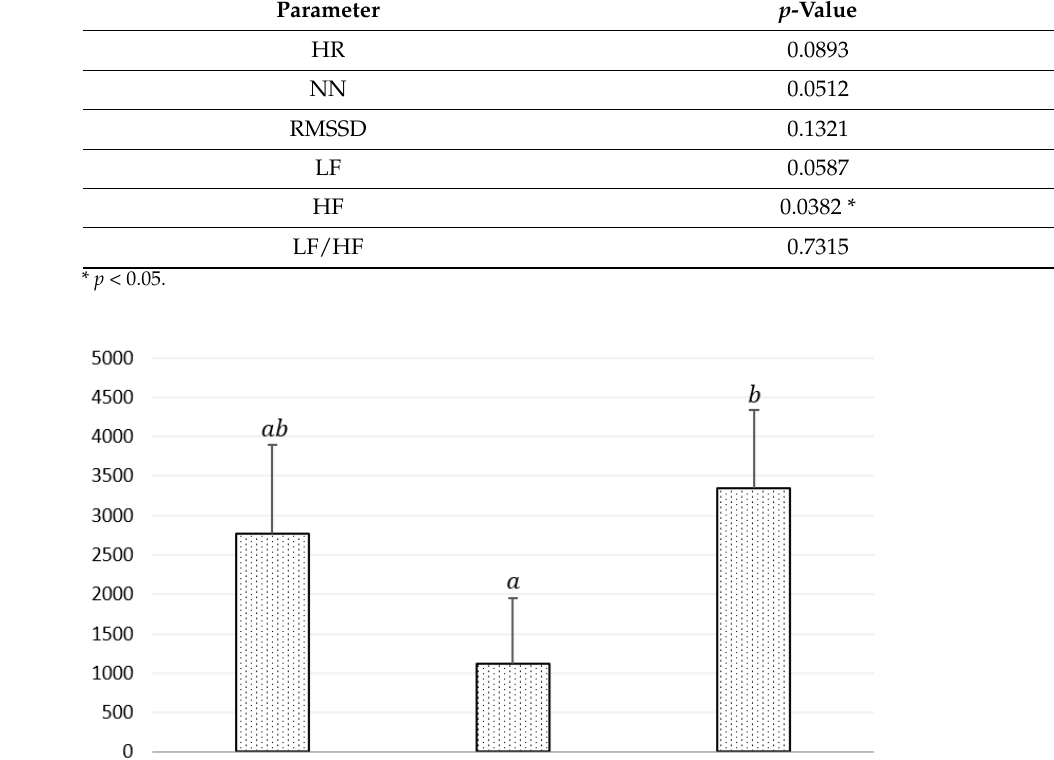
Table 3. The influence of experimental conditions on HR and HRV parameters: ANOVA results.